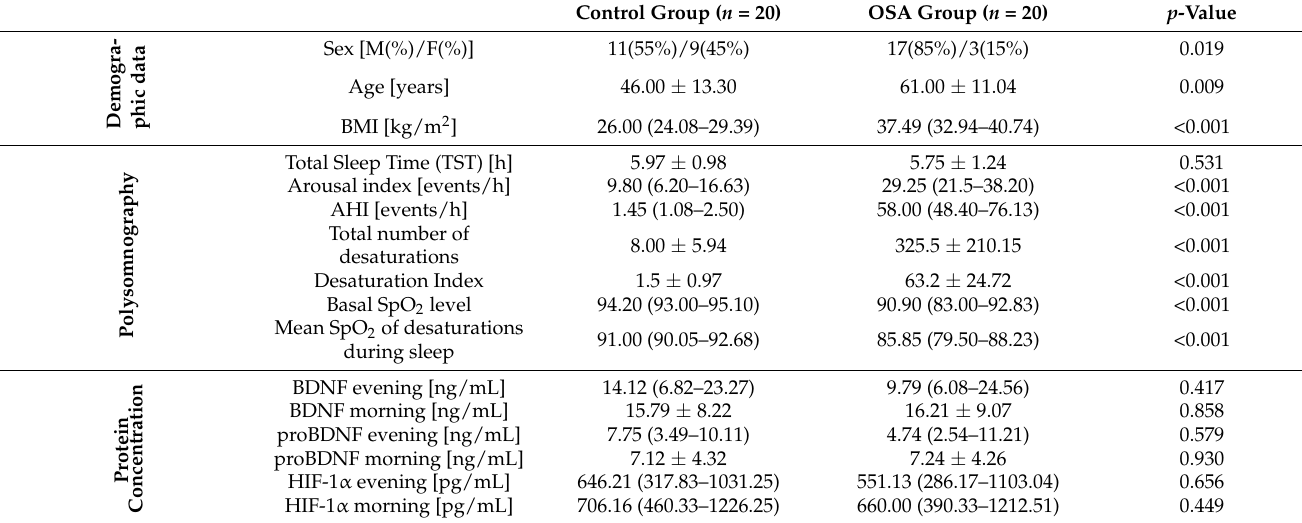
Table 1. Baseline characteristics of the study